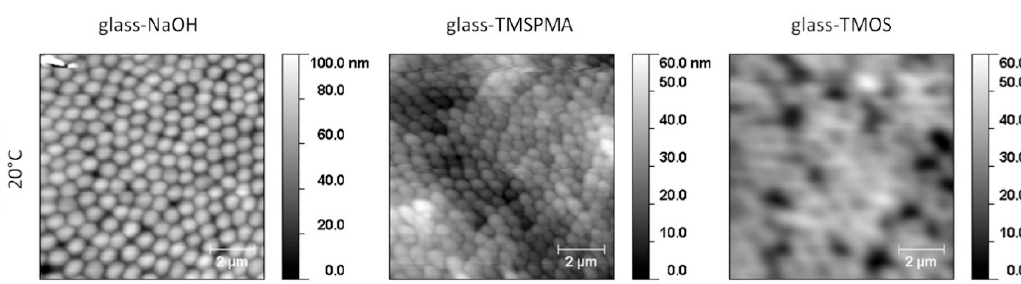
Figure 6. AFM images of PNIPAm b films spin-coated on glass-OH, glass-TMSPMA and glass-TMOS at 5000 rpm from a dispersion of 3 wt%, after being washed in water at 20 °C.